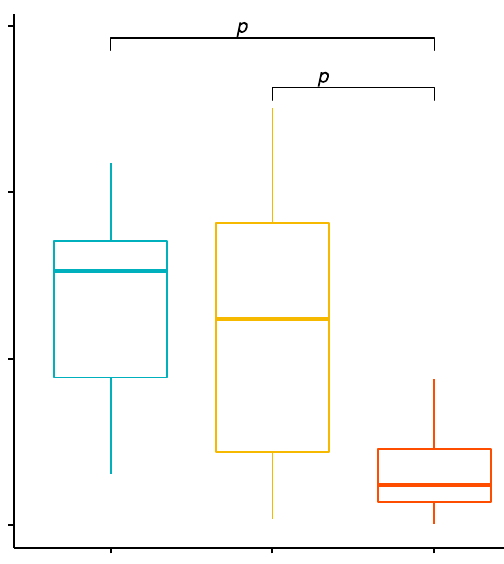
Figure 6. Percentage of CD8 +/ TLR-4 + T lymphocytes (among CD8 + cells; %) in patients with GD before treatment, after euthyroidism and in the control group.